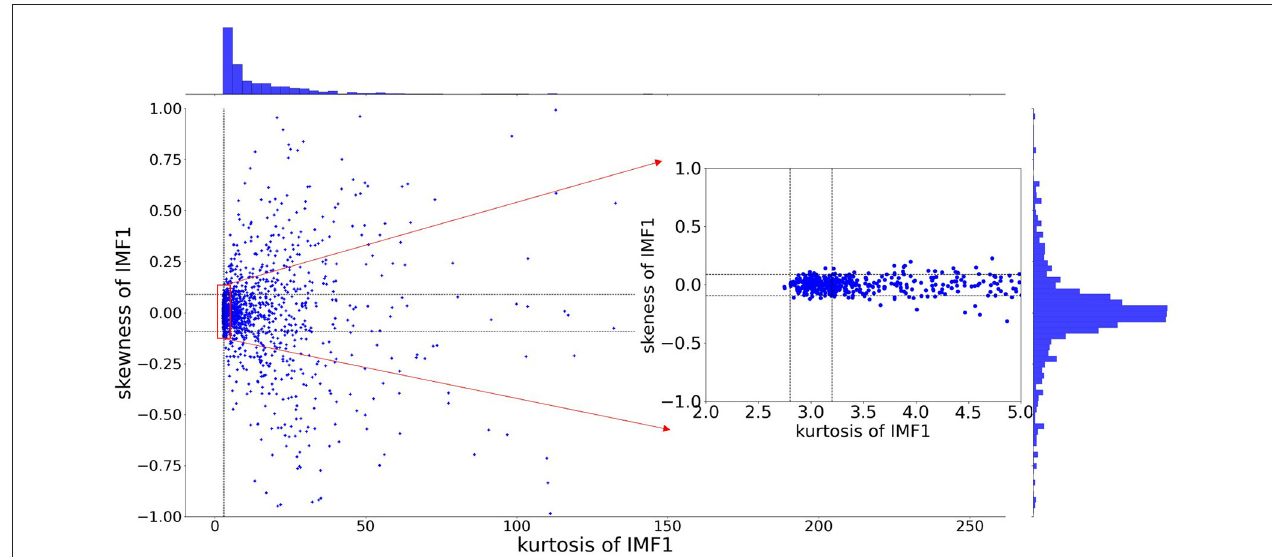
FIGURE 7 | The distribution of skewness and kurtosis for the first order IMF extracted from EEG signal (at PF1 electrode for all 1,373 trials).